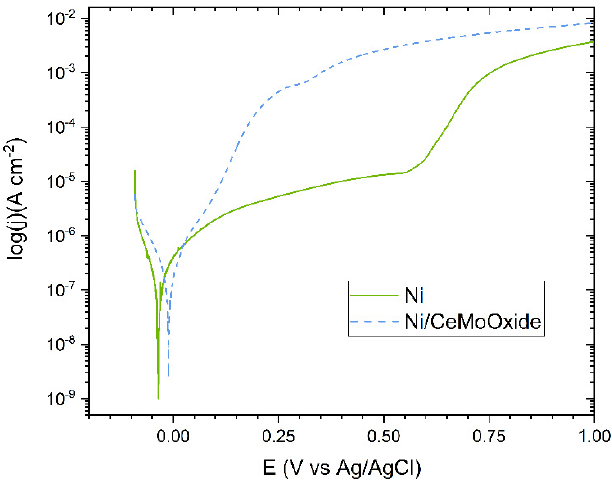
Figure 5. Corrosion potential ( E corr ) recorded for blank and composite Ni coatings during 168-hour exposure to 0.05 M NaCl solution.